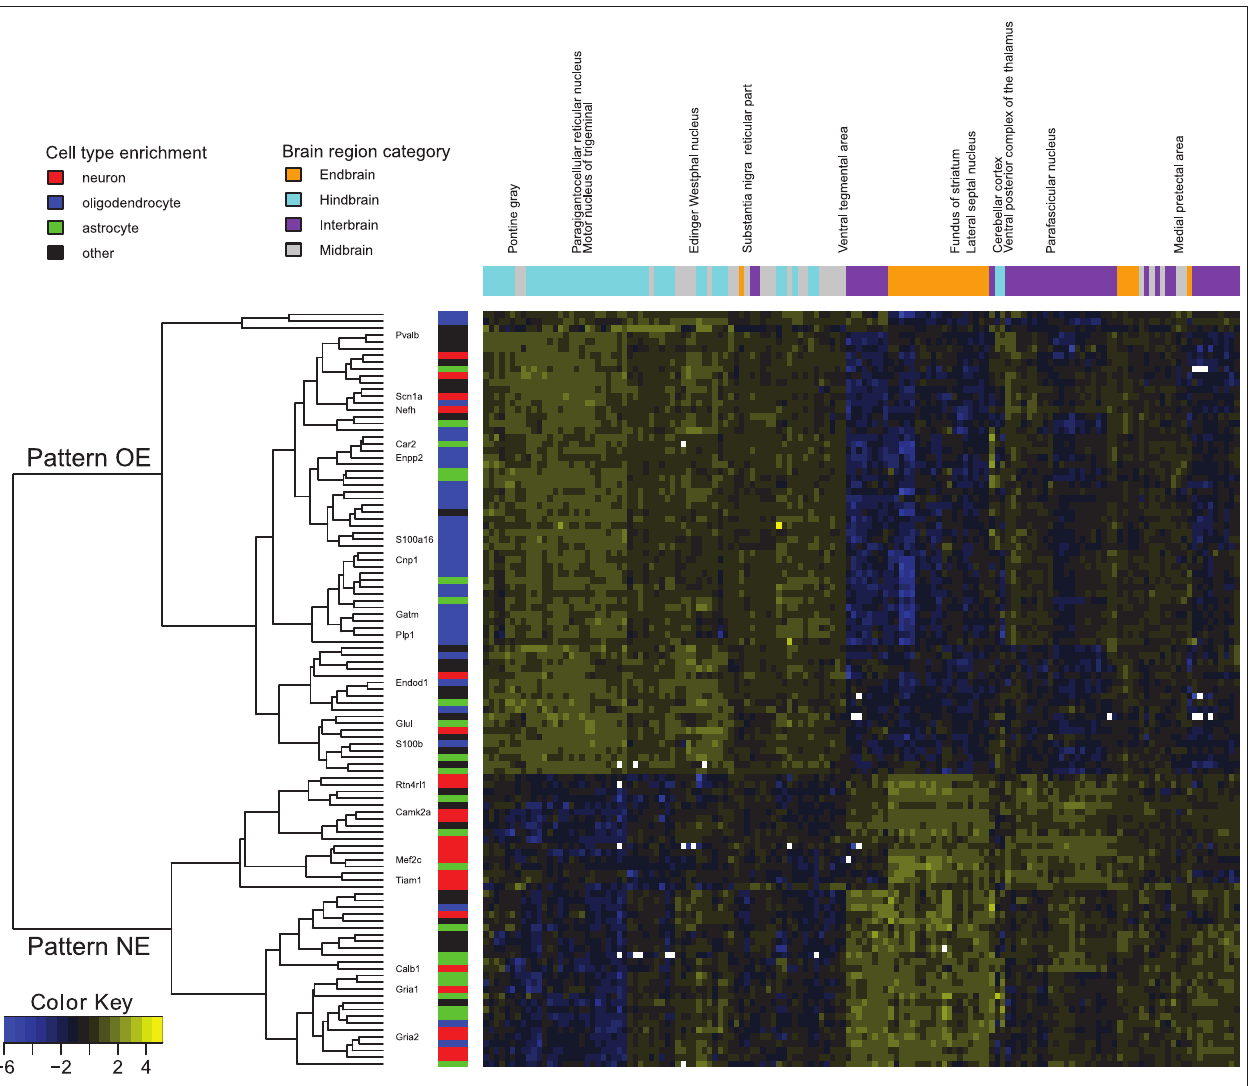
oligodendrocytes (blue) is marked (Cahoy et al., 2008). The dendrogram shows the split between pattern NE and pattern OE. Brain regions are colored as orange for endbrain, cyan for hindbrain, purple for interbrain, and gray for midbrain. Expression data for each gene was normalized to mean zero and variance one